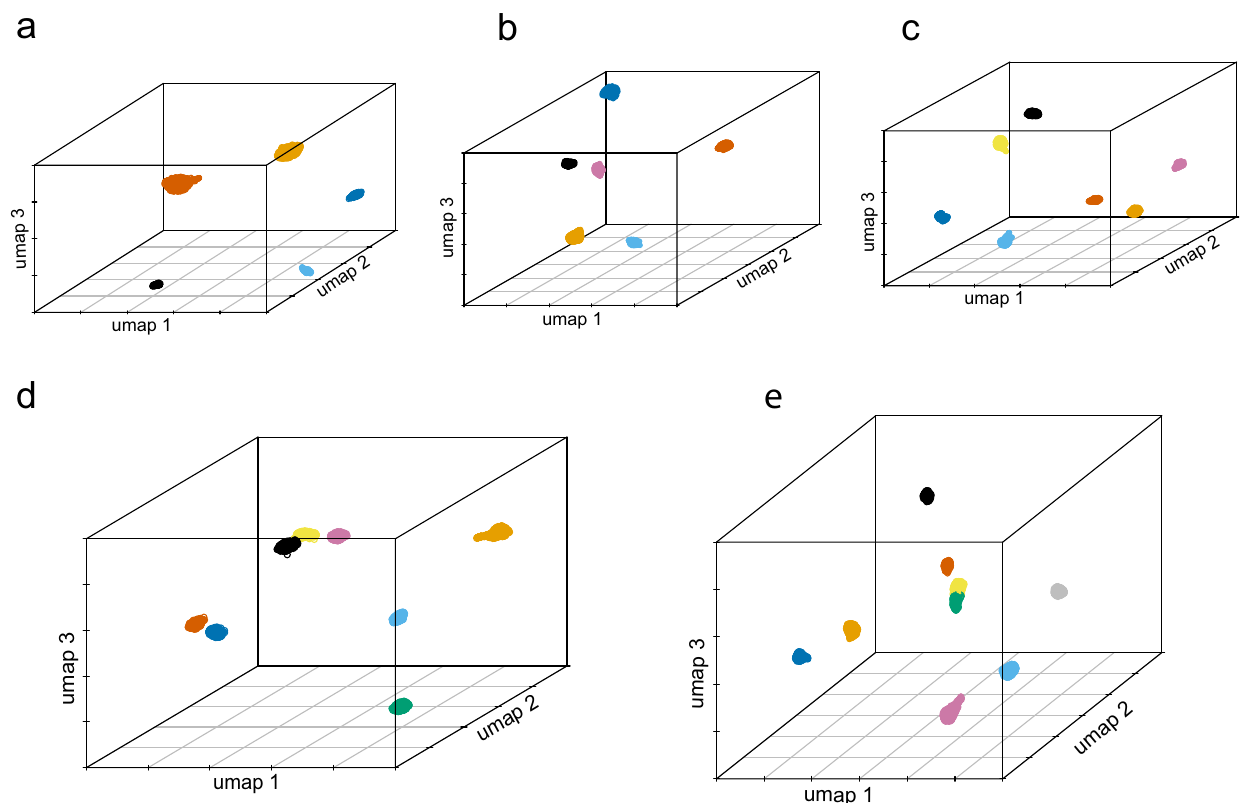
Fig. 3 Deconvolution of balanced in silico mixtures involving 5 – 9 individual contributors via de-goulash analysis of single-cell transcriptome sequencing data. a Mixture of fi ve individuals, b mixture of six individuals, c mixture of seven individuals, d mixture of eight individuals, and e mixture of nine individuals. Colour codes denote the different individuals from the respective mixtures. De-goulash uses a two-step approach with fi rst iteration based on mtDNA SNPs and second iteration based on genome-wide